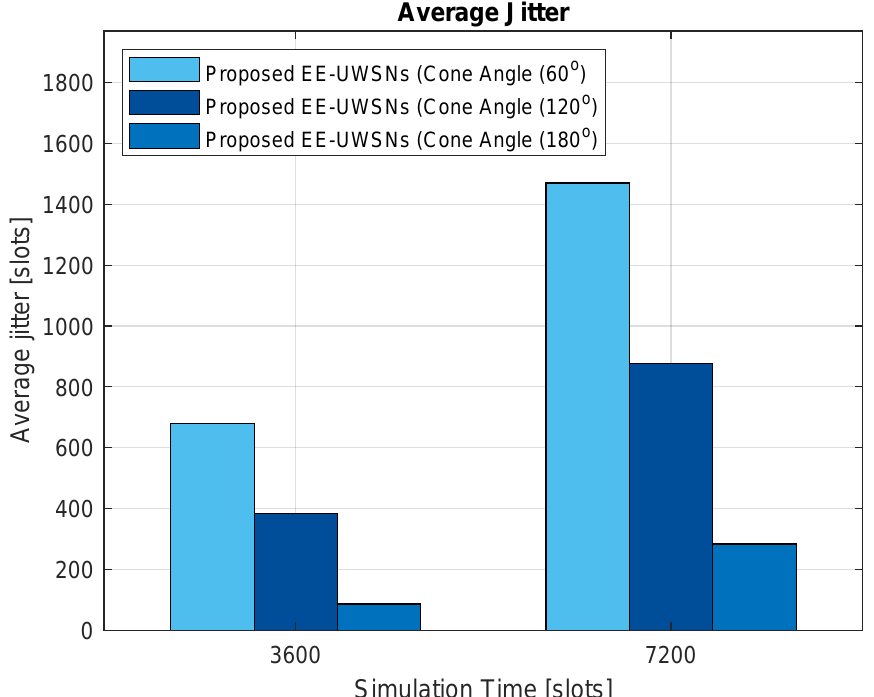
Figure 15. The effect of changing cone angle on